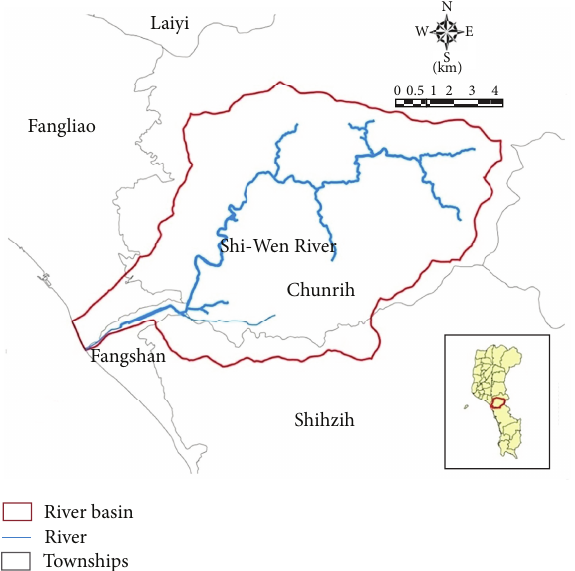
Figure 1: A sketch of Shi-Wen River basin.